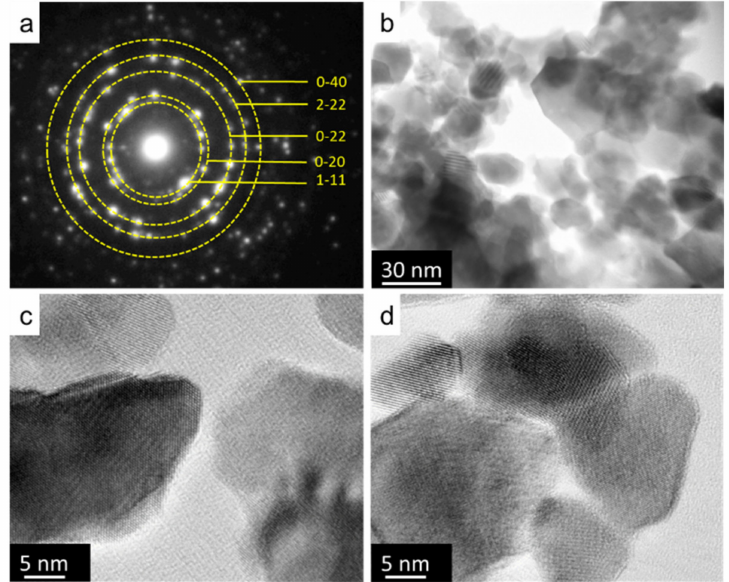
Figure 2. TEM ( a ) electron diffraction pattern and ( b – d ) micrographs of SDC nanoparticles obtained by sintering the SDC-Glucose hybrid material in argon and subsequently calcining it in